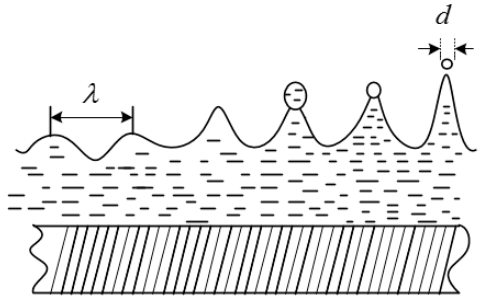
Figure 1. Atomization model diagram.